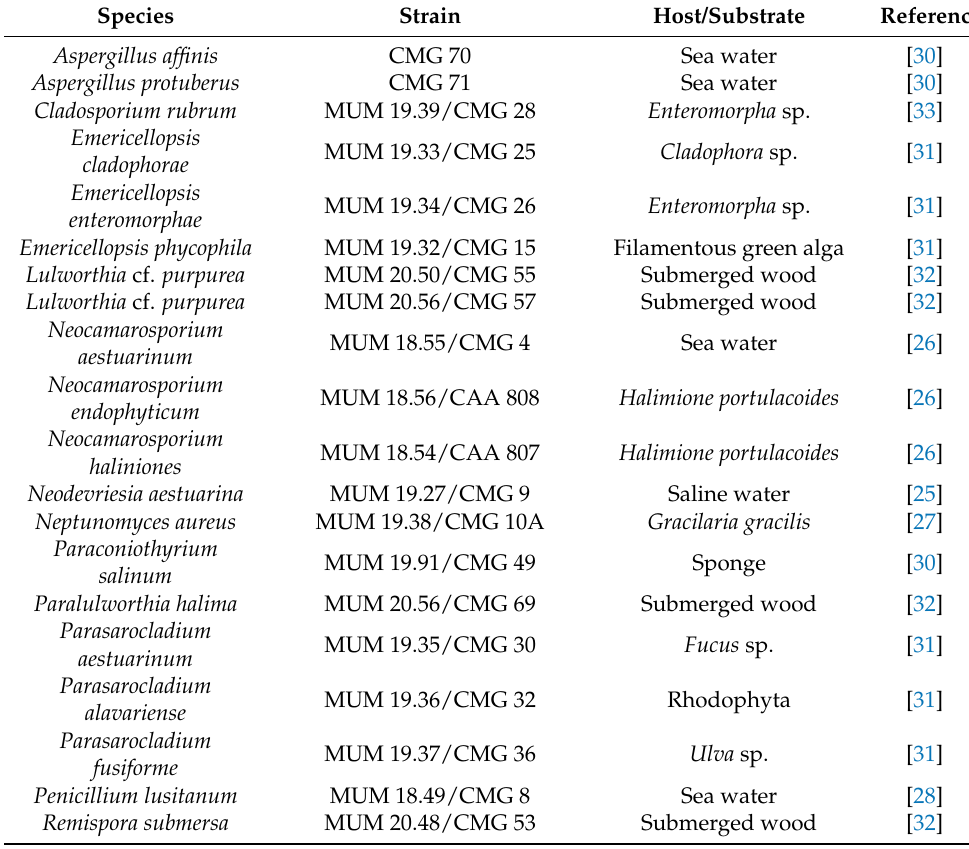
Table 1. List of fungal strains used in this